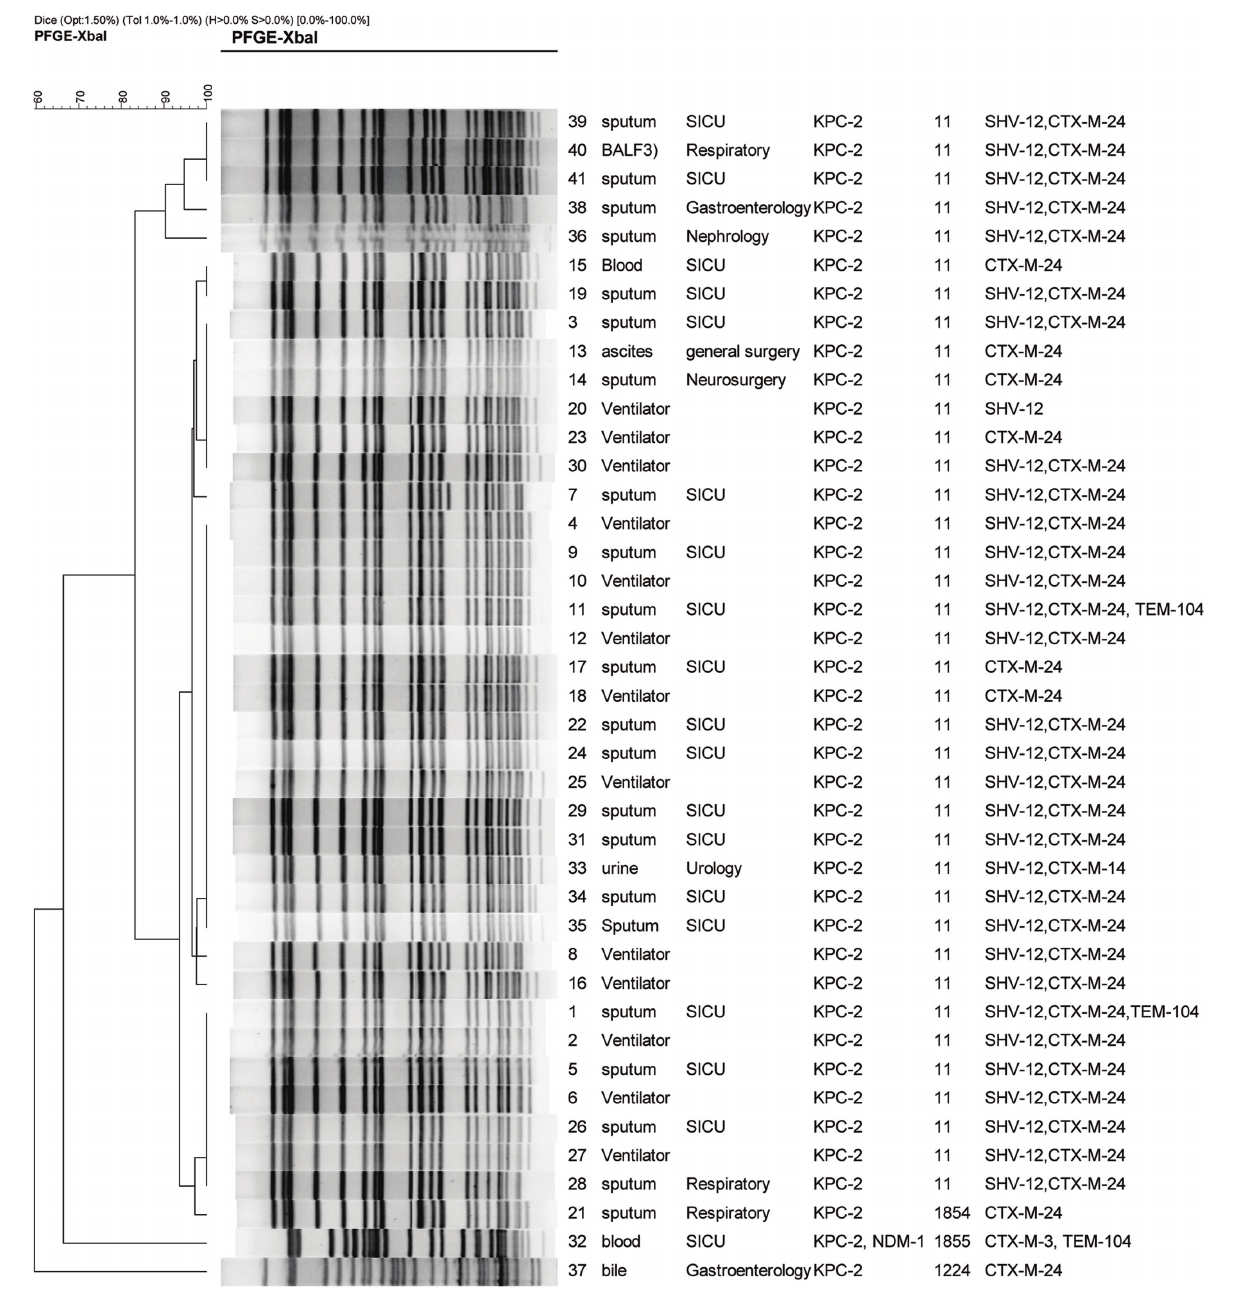
However, to the best of our knowledge, coexistence of bla KPC − 2 and bla CTX − M − 24 in one organism is first